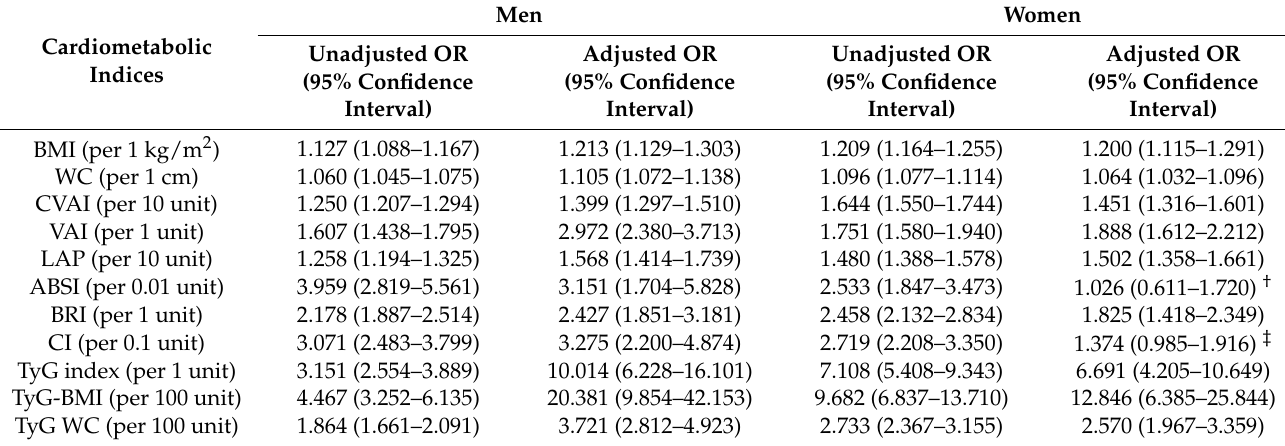
Table 2. Unadjusted and multivariate-adjusted odds ratios for 10-year ASCVD risk ≥ 7.5% among cardiometabolic